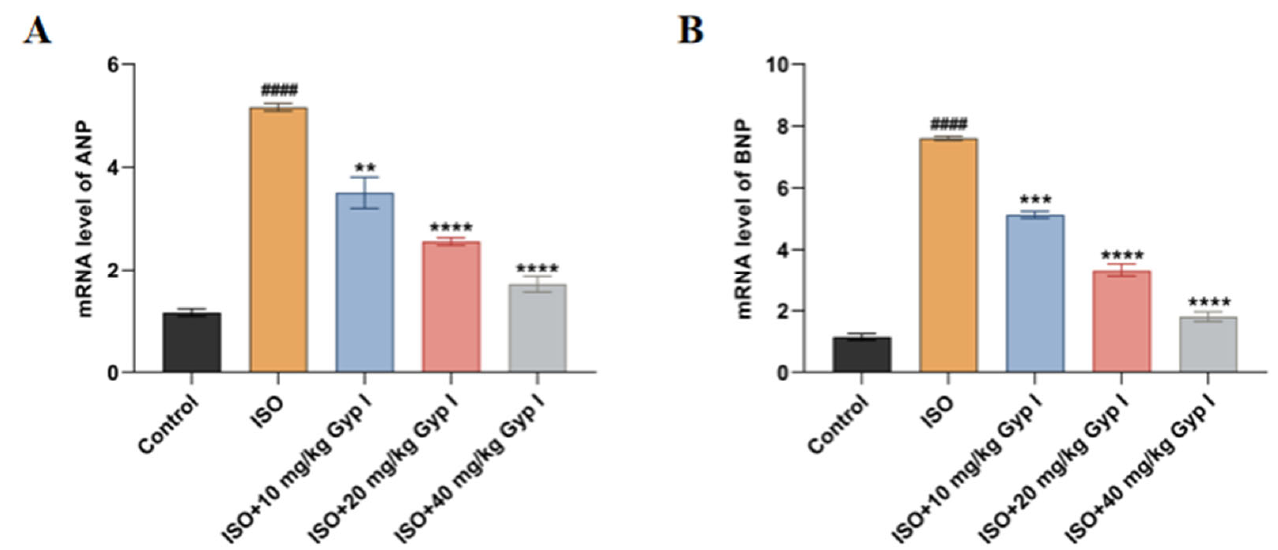
Figure 8. Effects of Gyp I on ISO-induced myocardial hypertrophy mRNA levels in mice: ( A ) ANP. ( B ) BNP ( n = 3, mean ± SD, ####: p < 0.0001 compared with Control group; **: p < 0.01, ***: p < 0.001, ****: p < 0.0001 compared with ISO group).